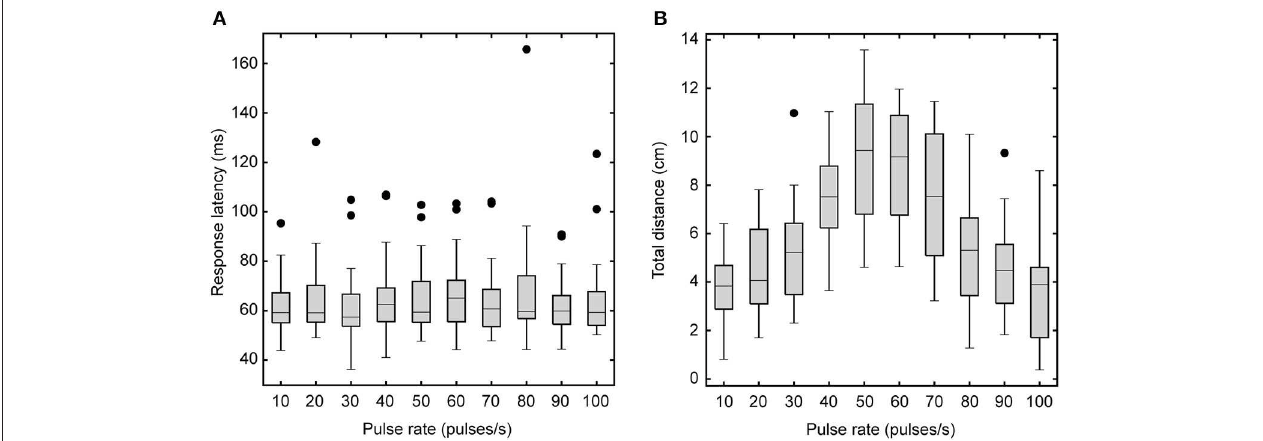
FIGURE 3 | Effects of song pulse rate on response latency and total walking distance. Box plots depict the first and third quartiles and median response latency (A) and walking distance (B) . Response latencies (A) do not vary with song pulse rate. However, total walking distance (B) varies with song pulse rate. Flies travel greater distances for the most preferred pulse rates. Whiskers show the most data extreme points that are not considered outliers, and closed circles indicate outliers.